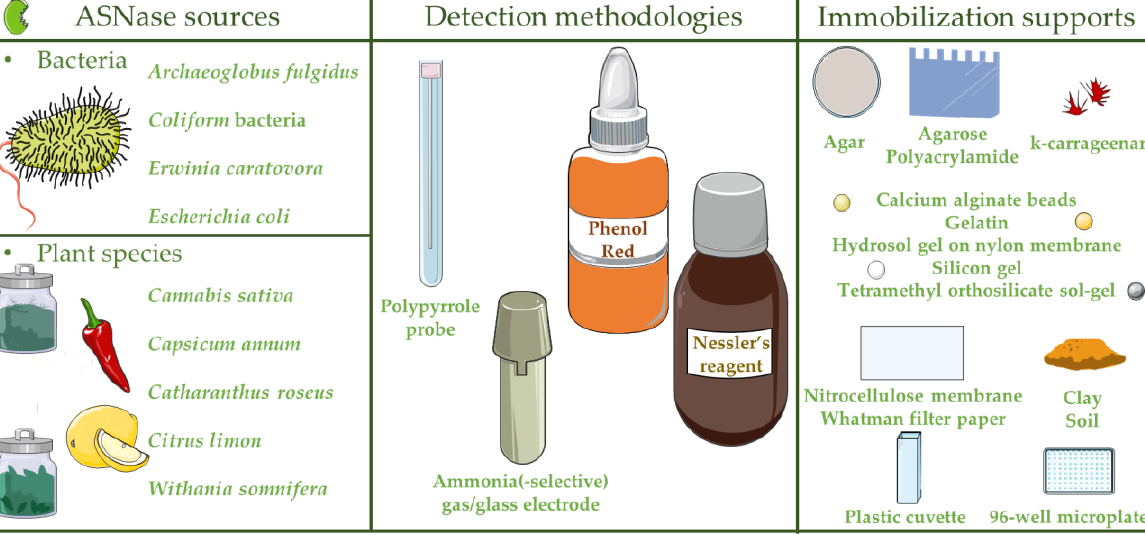
Figure 2. ASNase-based biosensors: ASNase sources, detection methodologies and immobilization supports.